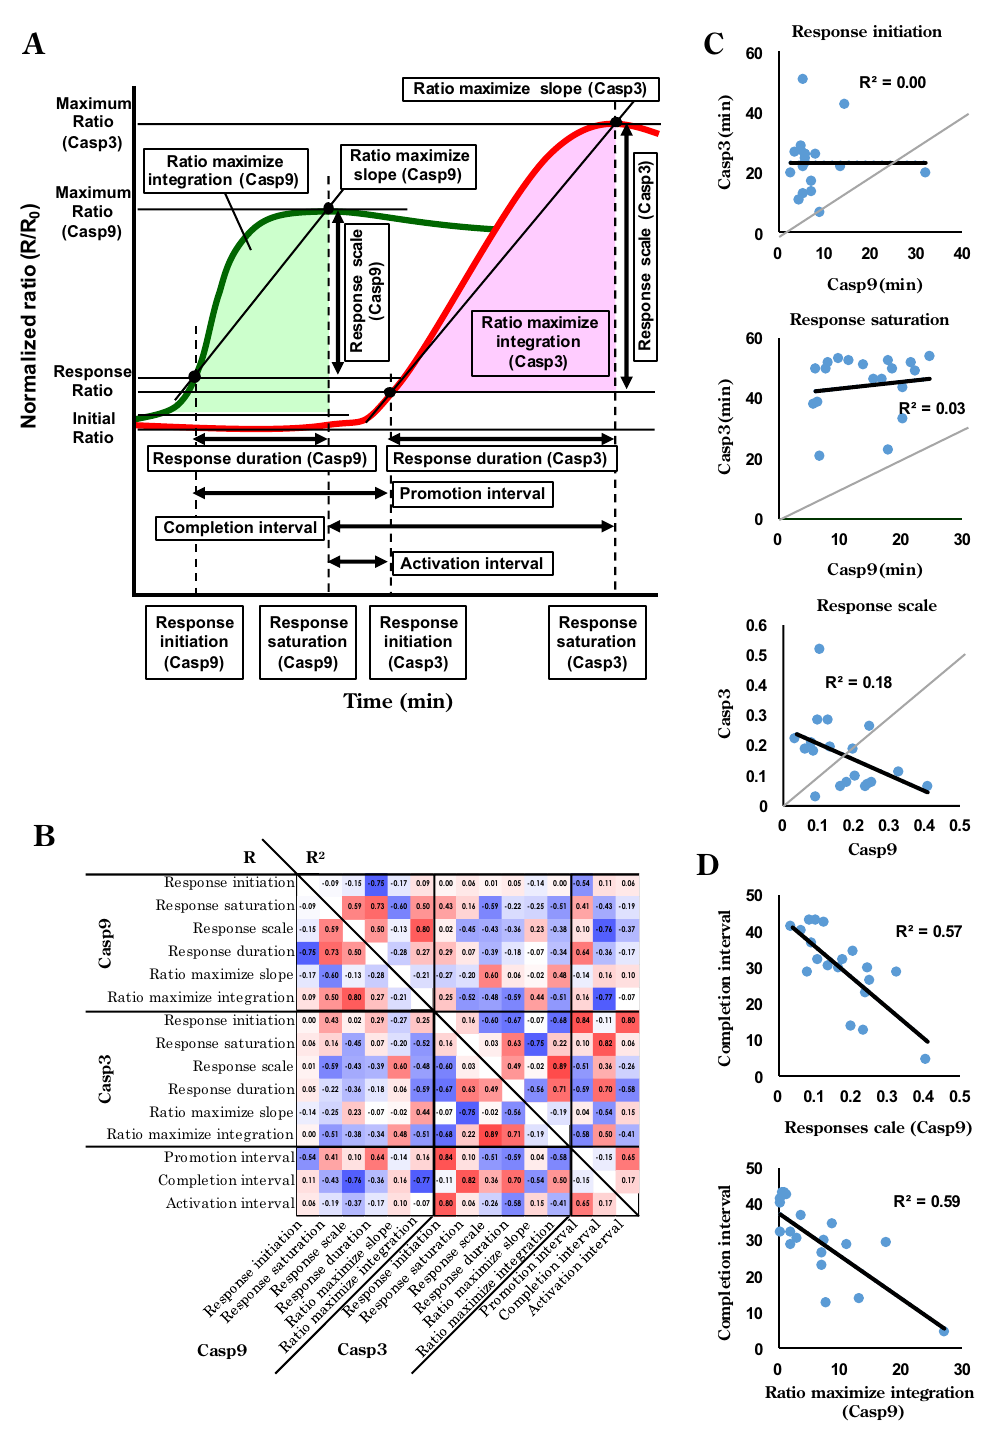
Figure 4. Indices defined to characterise caspase behaviour and statistical analysis of caspase-9 and -3 activation correlations. ( A ) Schematic of each caspase (green: caspase-9, red: caspase-3) activation profile categorising response strengths (response scale, maximum ratio, ratiomaximise integration), times (response initiation, response saturation, response duration, promotion interval, activation interval, completion interval), and rates (ratiomaximise slope). ( B ) Heatmap of caspase-9 and -3 activation correlations showing correlation coefficients (R: lower half) and coefficients of determination (R 2 : upper half) of all indicator combinations with positive correlations in red and negative ones in blue. (n = 19 cells) ( C ) Correlations between ratio initiation, ratio saturation, and ratio scale of caspase-9 and -3. ( D ) Correlations between completion intervals and response scale or ratiomaximise integration of